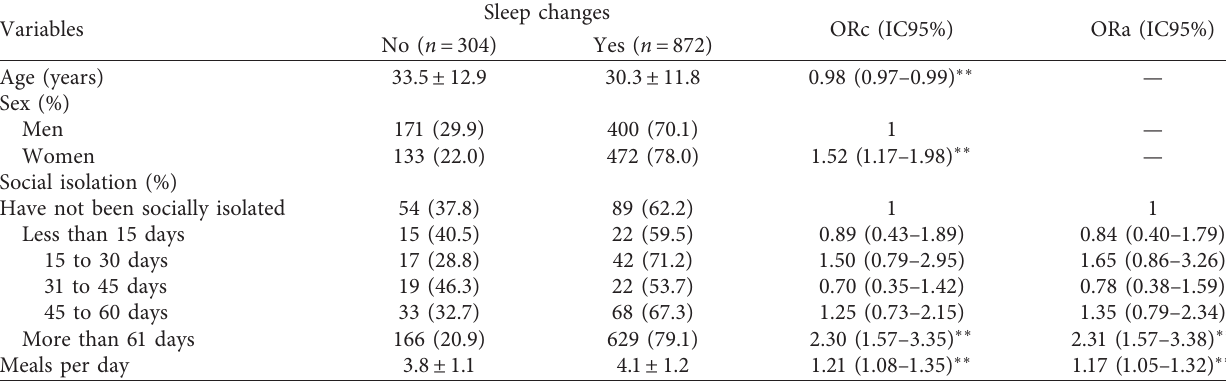
Table 5: Factors associated with sleep changes during the COVID-19 pandemic in the study